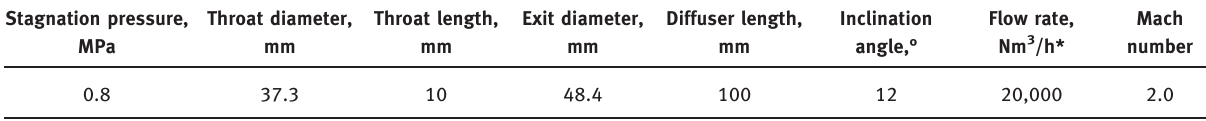
Table 1: Design parameters of oxygen lance nozzle. Stagnation pressure,